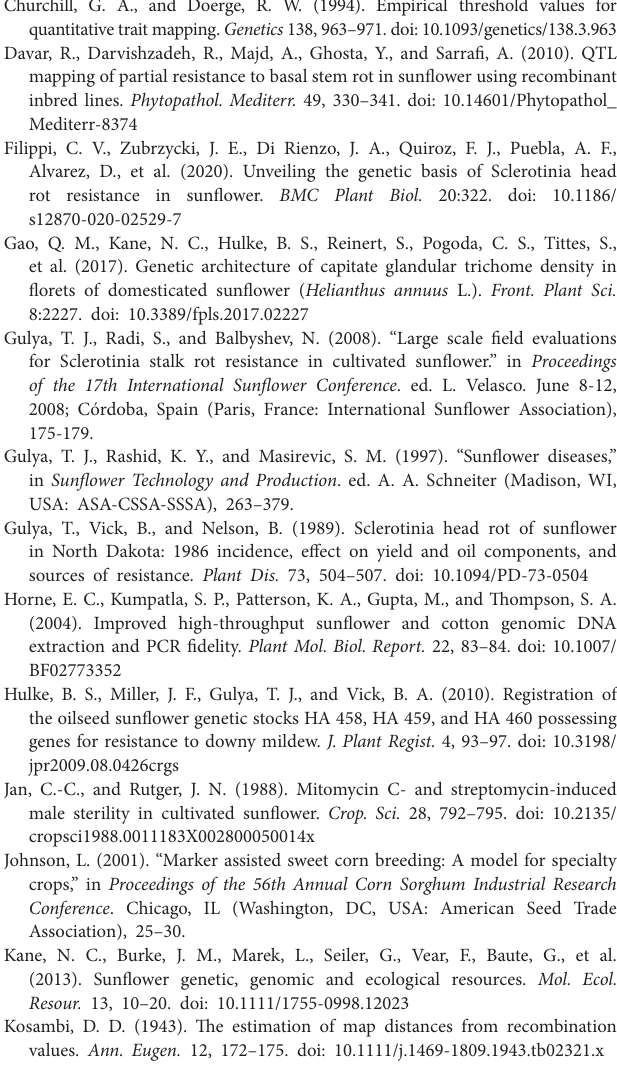
Supplementary Figure 1 | Heat map showing the performance of 174 individuals of the HA 89/ H. praecox advanced backcross population evaluated for Sclerotinia basal stalk rot resistance in the greenhouse and field environments. Area under disease progress curve (AUDPC) and disease rating (DR) were measured in the greenhouse in 2018, and disease incidence (DI) were measured in the Carrington, ND field in 2017 and